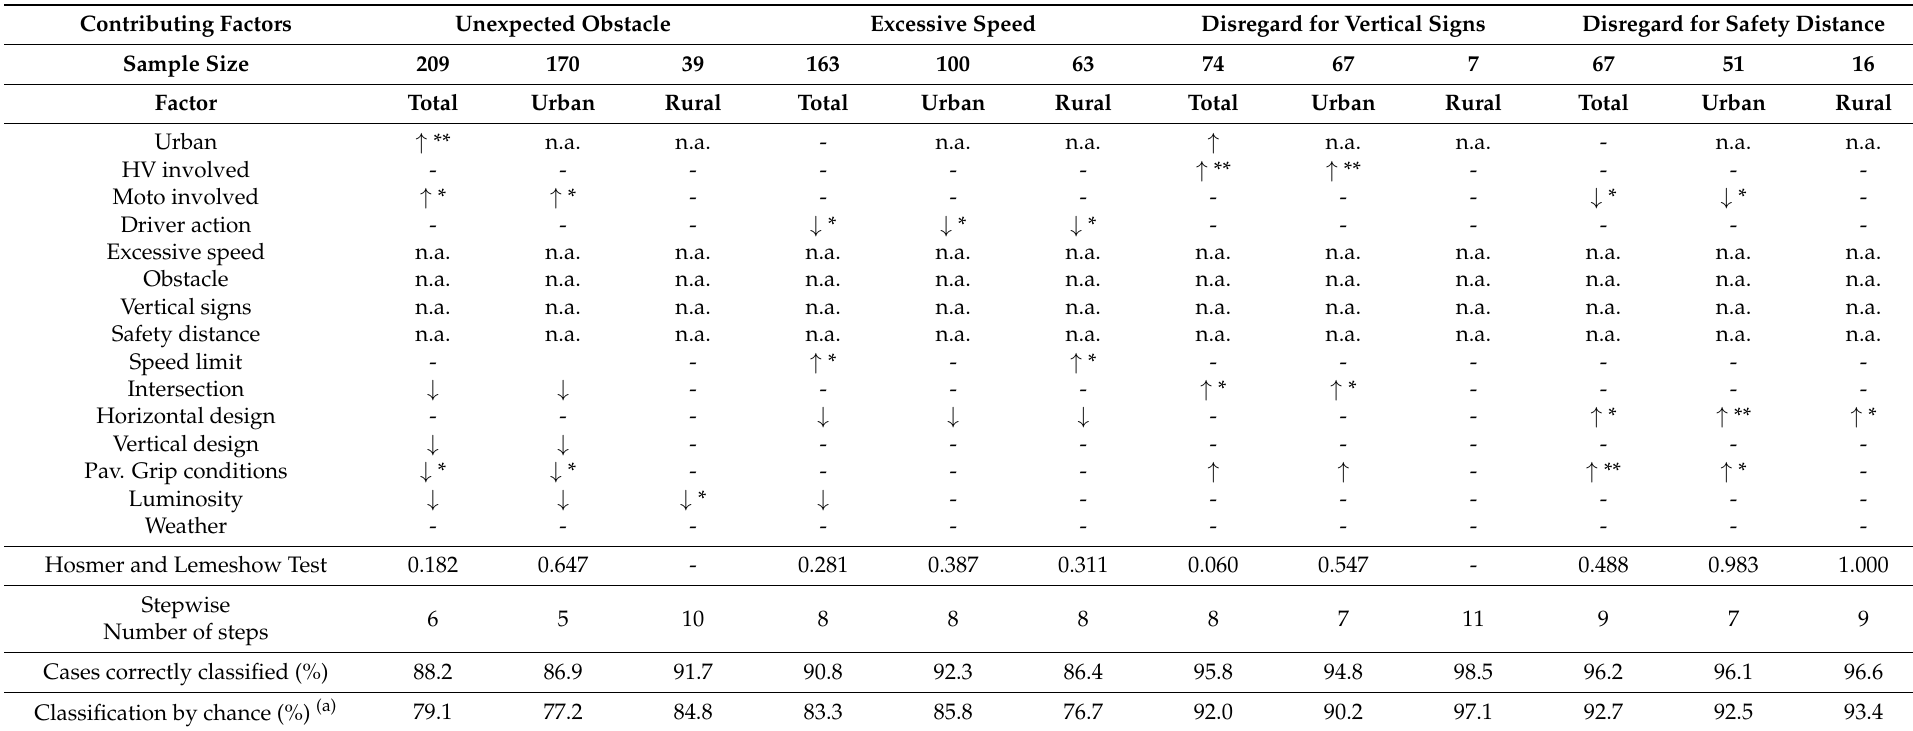
Table 7. Summary of model qualitative findings for contributing